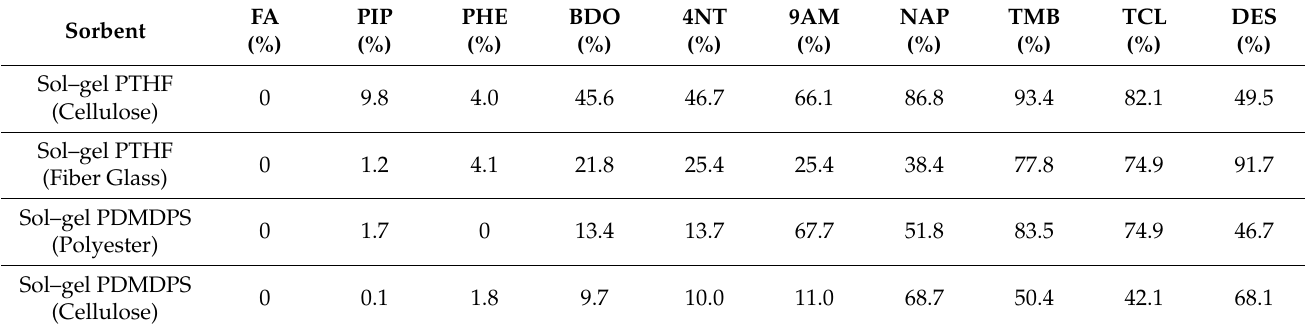
Table 3. Comparison of extraction recovery between different fabric